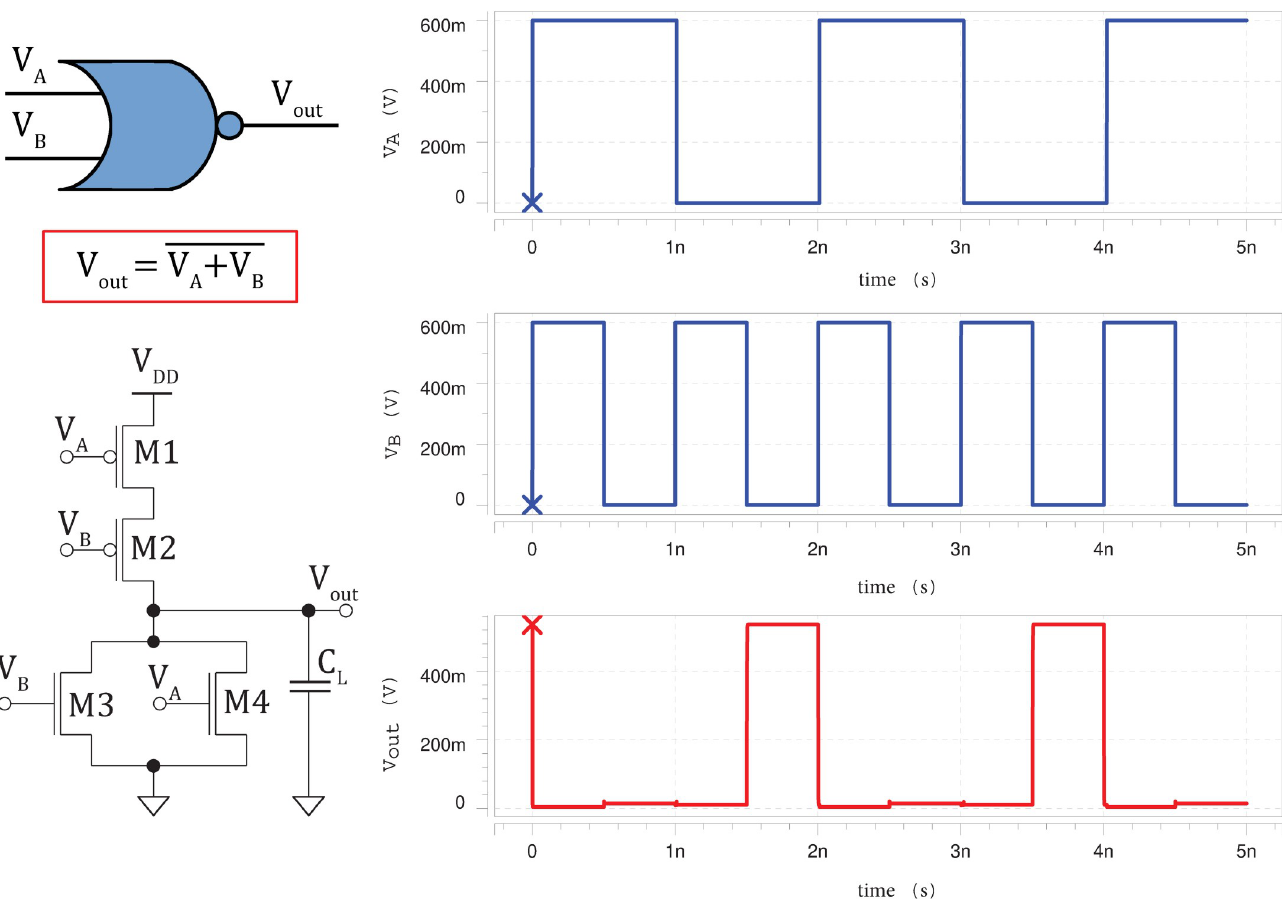
Fig 7. Schematic circuit diagram of silicene-based 2-input NOR gate ( L int = 1 μm ) with its input (blue) and corresponding output waveforms (red).